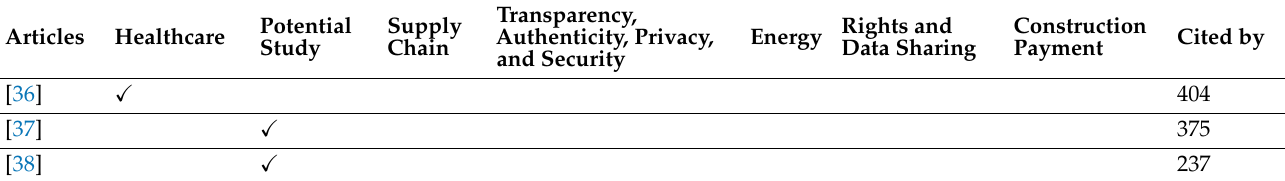
Table 3. A summary of the major uses of the top 50 cited